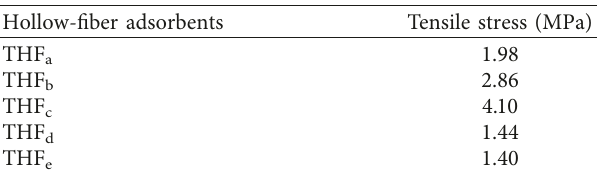
Table 6: Tensile stress analysis of hollow-fiber adsorbents with different compositions.